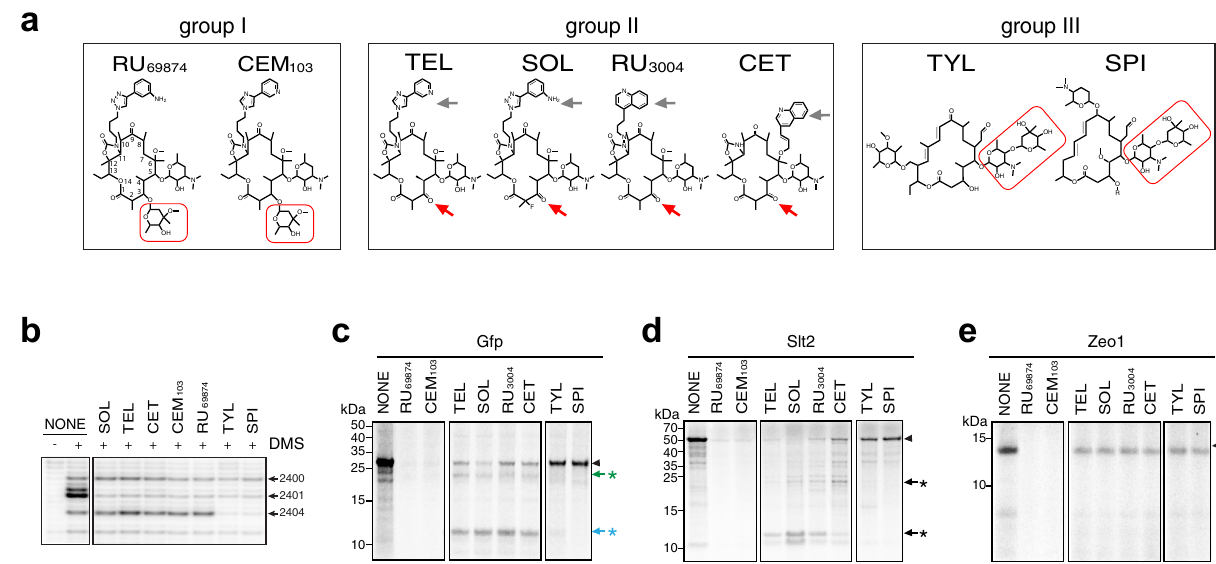
Fig. 6 The structure of the macrolide affects selective inhibition of translation. a Structures of representative macrolide antibiotics grouped according to their chemical features: group I, 14-atom macrolactone ring carrying C3 cladinose sugar (framed in red); group II, 14-atom macrolactone ring with C3 keto group (red arrow) and extended alkyl-aryl side chain (gray arrow); group III, 16-member macrolactone with C5 disaccharide chain (framed in red). b Chemically different macrolides readily bind to the yeast G2400A mutant ribosome as revealed by the protection of 25S rRNA residues A2400(2058), A2401(2059) and, in the case of the group III compounds, A2404(2602) from DMS modi fi cation. The drugs were present at 100 µ M. The primer extension products were resolved in the denaturing 6% polyacrylamide gel. Control samples ( “ NONE ” ) contained no macrolides. c – e SDS-gel analysis of the [ 35 S]-labeled protein products accumulated during translation in the yeast cell-free system of templates encoding the Gfp reporter ( c ) or the Slt2 ( d ), and Zeo1 ( e ) yeast proteins. Translation reactions were supplemented with 100 µ M of the indicated macrolides. The control reaction (NONE) contained no antibiotic. Arrowheads and arrows/asterisk represent the bands corresponding to the full-length and truncated products, respectively. The uncropped gel can be found in the Source data fi le. b – e Representative gels of two independent